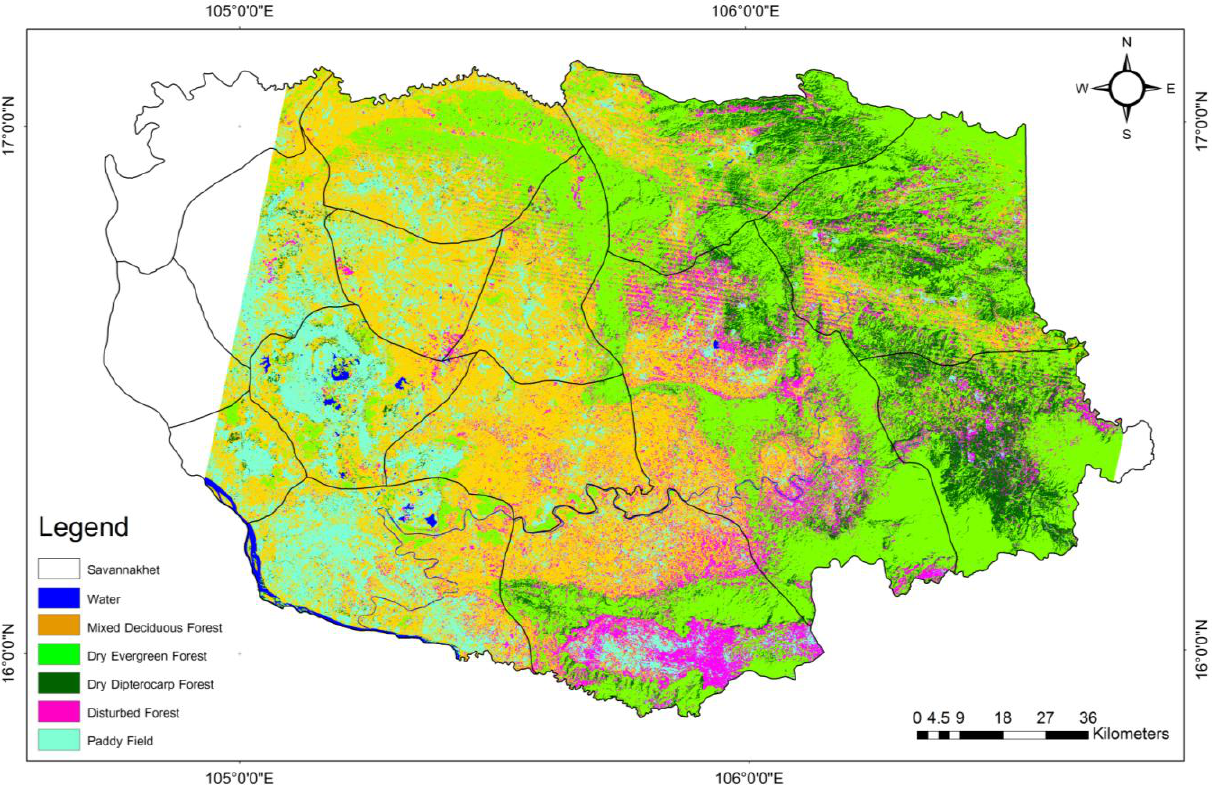
Figure 4. Land-cover types in the Savannakhet